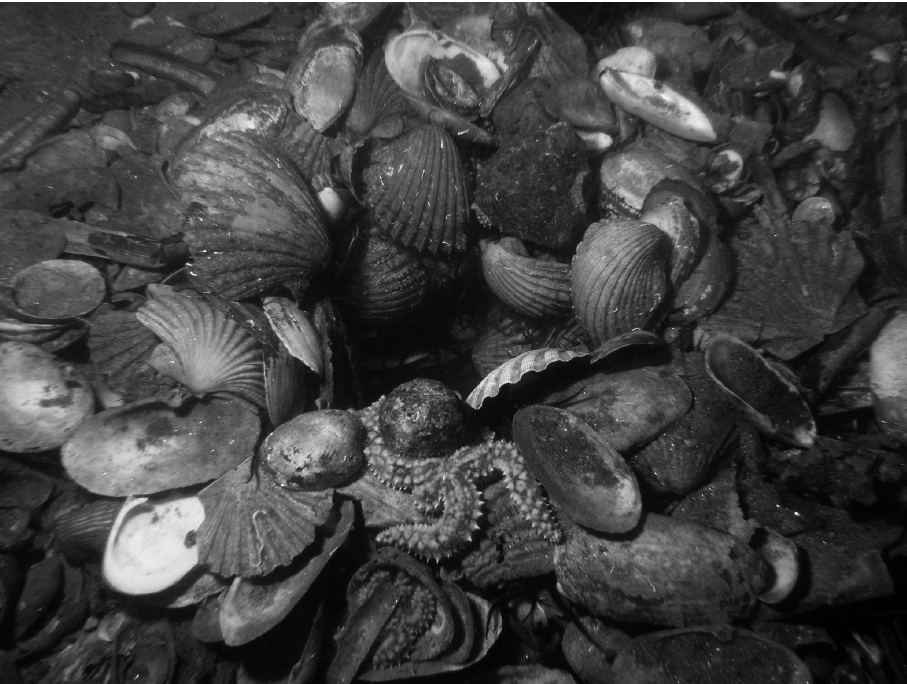
Fig. 2. – One of the O. vulgaris dens found on the sandy bottom of the Rodas inlet (NAPAIG), showing the central hole and the